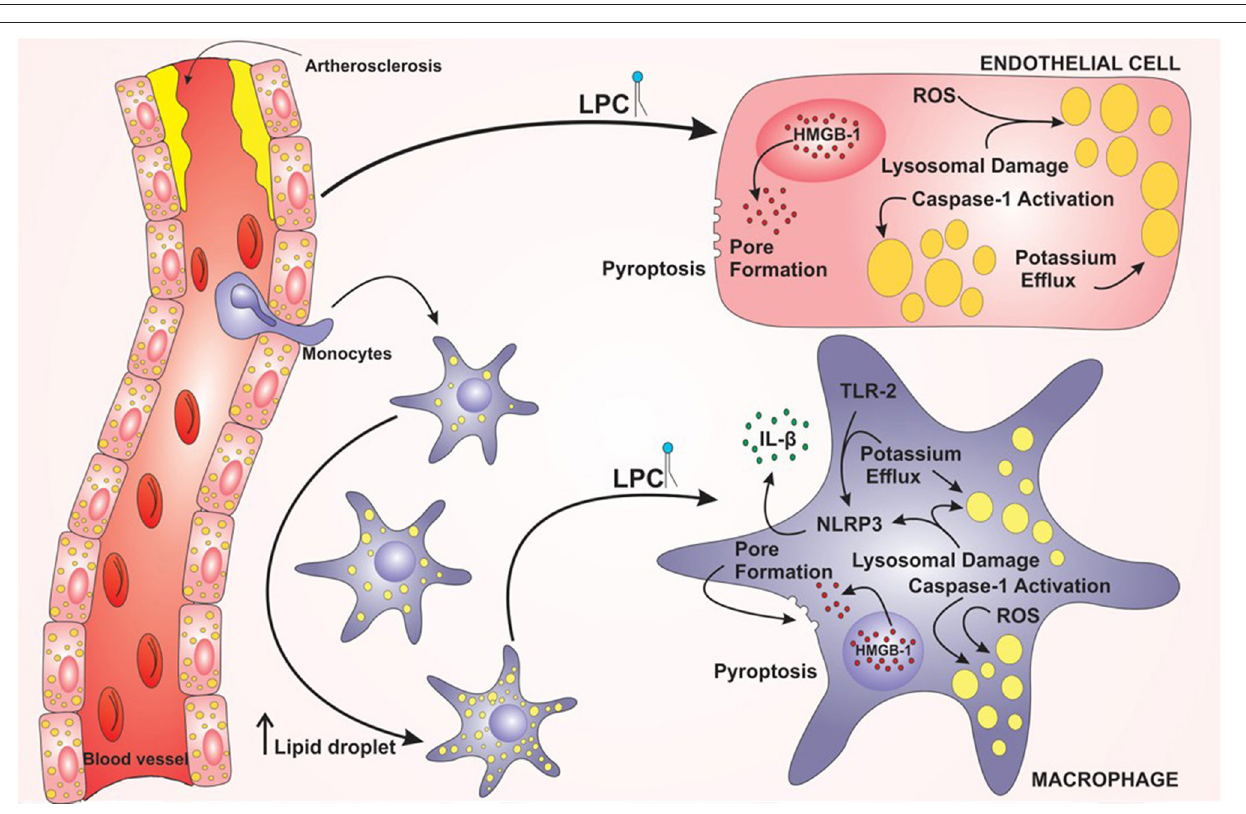
FIGURE 7 | Model proposed for lysophosphatidylcholine (LPC)-mediated inflammasome activation and foam cell formation in human monocytes and endothelial cells. LPC plays a major role in the establishment and progression of atherosclerosis. LPC can increase the lipid droplets in macrophages and endothelial cells and promote inflammation through the activation of the NLRP3 Inflammasome. In addition, LPC can induce cell death by pyroptosis through the translocation of HMGB1 from the nucleus to the cytoplasm and pore